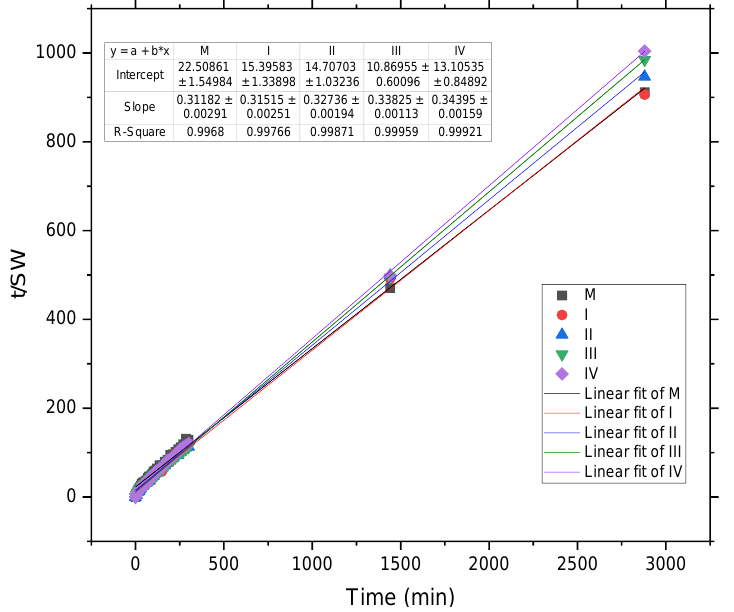
Figure 4. Graphical representation of the Schott equation for hydrogel samples with (I, II, III, and IV) and without GO (M).